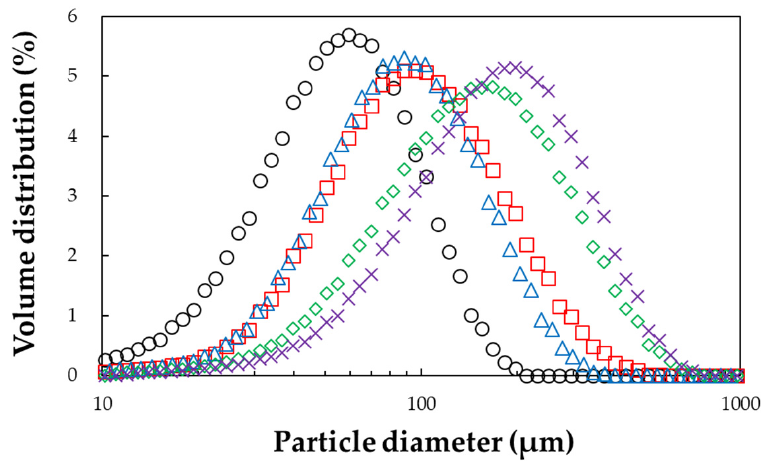
Figure 4. PSD of non-agglomerated and agglomerated guar gum (GG) with various concentrations of sucrose binder: ( ◯ ) non-agglomerated GG, ( □ ) GG–0%, ( △ ) GG–10%, ( ◇ ) GG–20%, and (×) GG–30%.